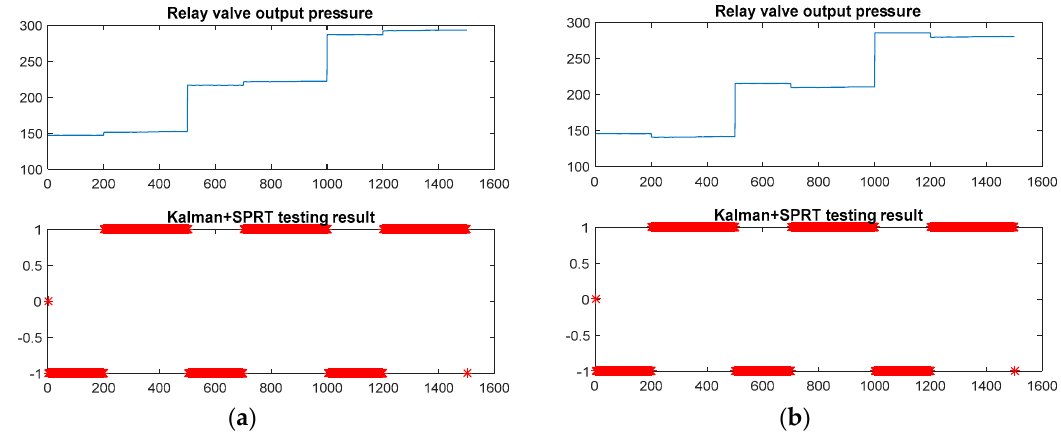
Figure 6. ( a ) Relay valve internal leakage Kalman and SPRT test results and ( b ) relay valve external leakage Kalman and SPRT test results.